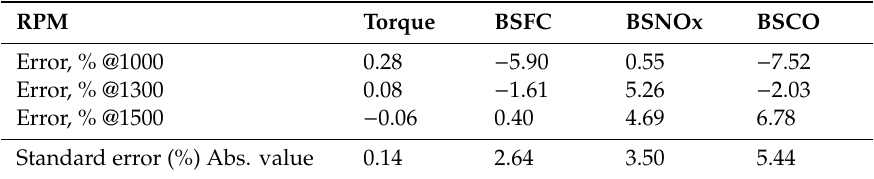
Table 5. Detailed errors and standard errors for validation results for data shown in Figure